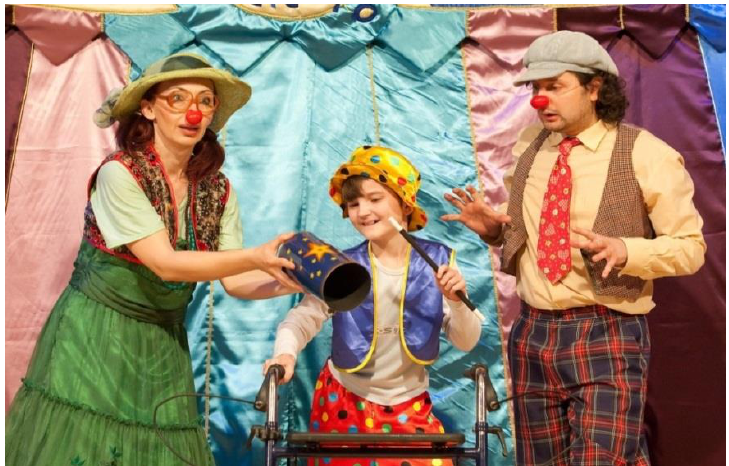
Figure 3. Performance of Circus Patientus in